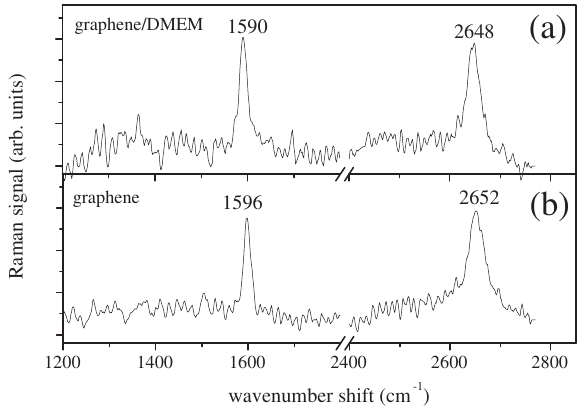
Figure 4. ( a ) Raman spectrum of graphene covered by the unexposed DMEM-A sample (0 Gy). ( b ) Raman spectrum of bare